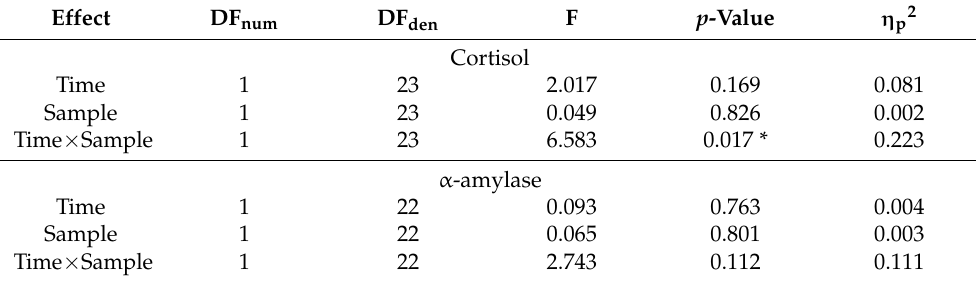
Table 3. Results of rm ANOVA of cortisol [nmol/L] (N = 24) and α -amylase [U/mL] (N = 23) in saliva with the factors time (before and after product application) and samples (AC and PL).